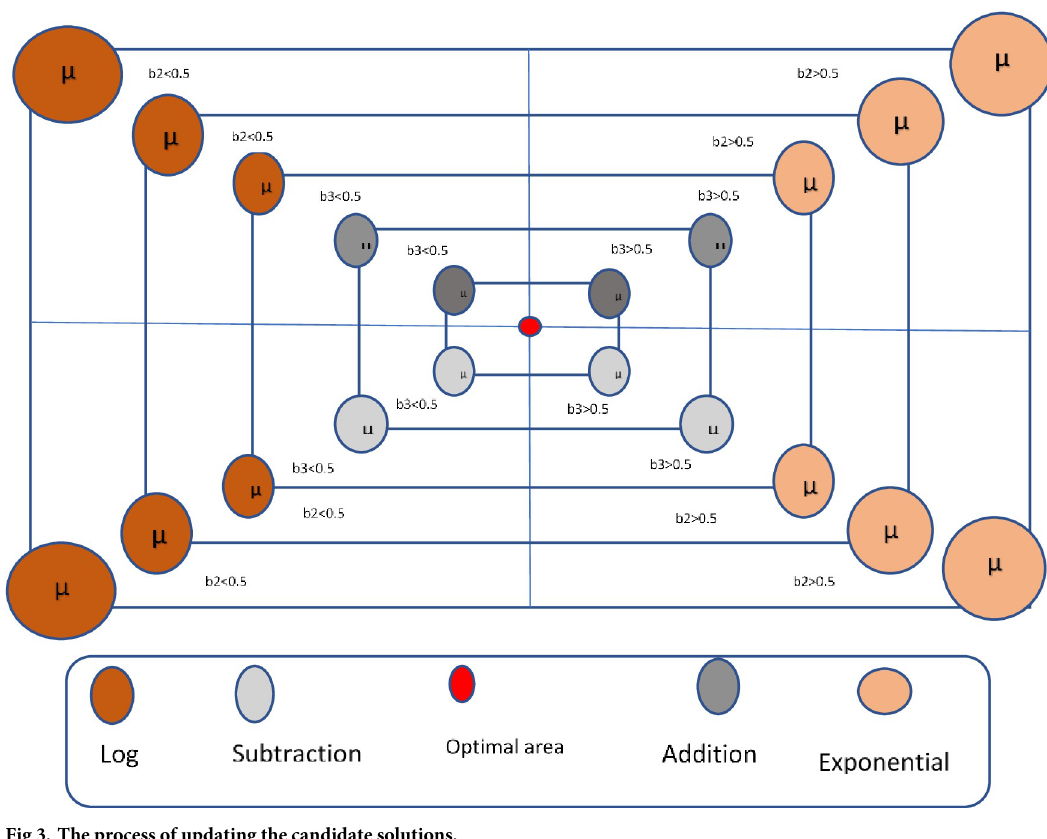
Fig 3. The process of updating the candidate